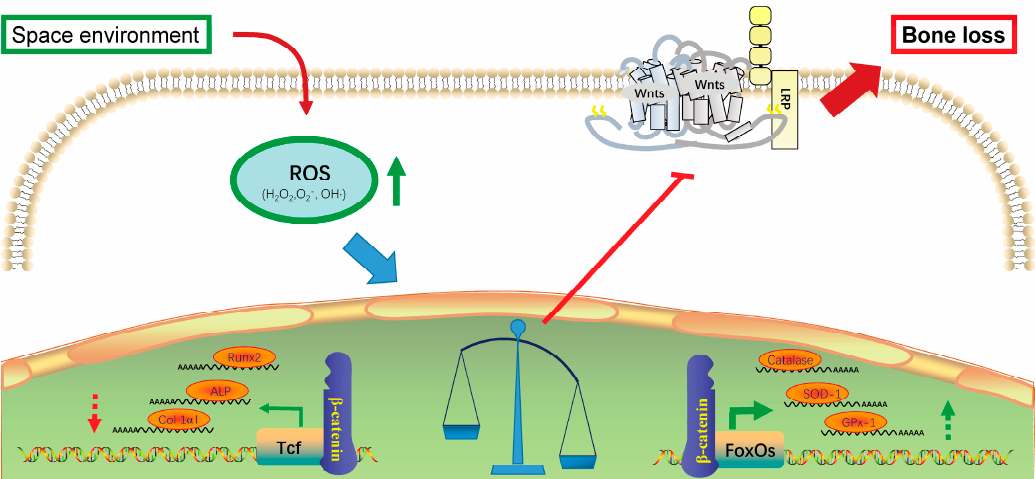
Scheme 1. The scheme of possible mechanism of space environment-induced bone loss: the increment of ROS caused by Space environment antagonizes the skeletal effects of Wnt/ β -catenin/Tcf by diverting β -catenin from Tcf—to FoxOs-mediated transcription. LRP: LDL receptor-related